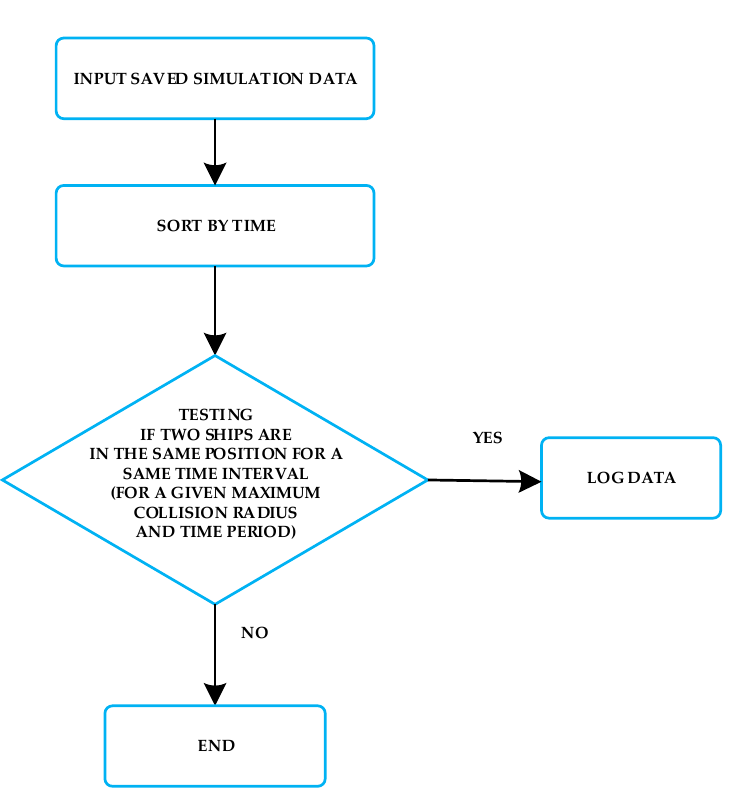
Figure 4. Collision probability estimation flowchart based on MC results (Step 4).